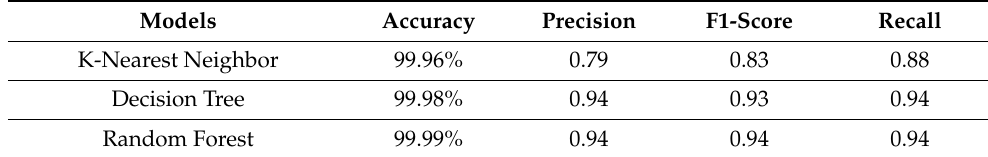
Table 5. Evaluation of ML Models.